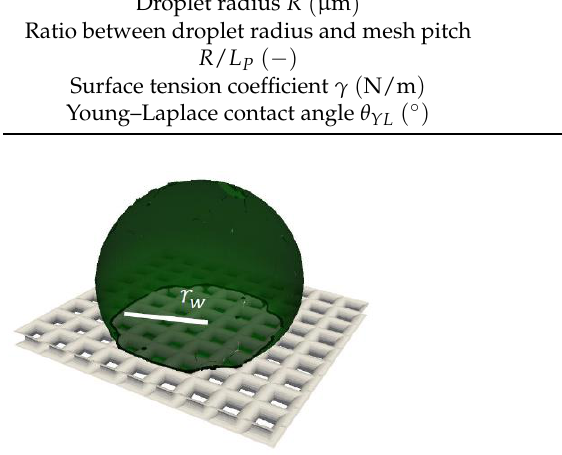
Figure 13. Visualization of the averaged wetting (clogging) radius. Table 6. Parameter space of the simulations of water–wire mesh screen interaction. Inlet Velocity 𝒖 ∞ (𝐦 𝐬⁄ )